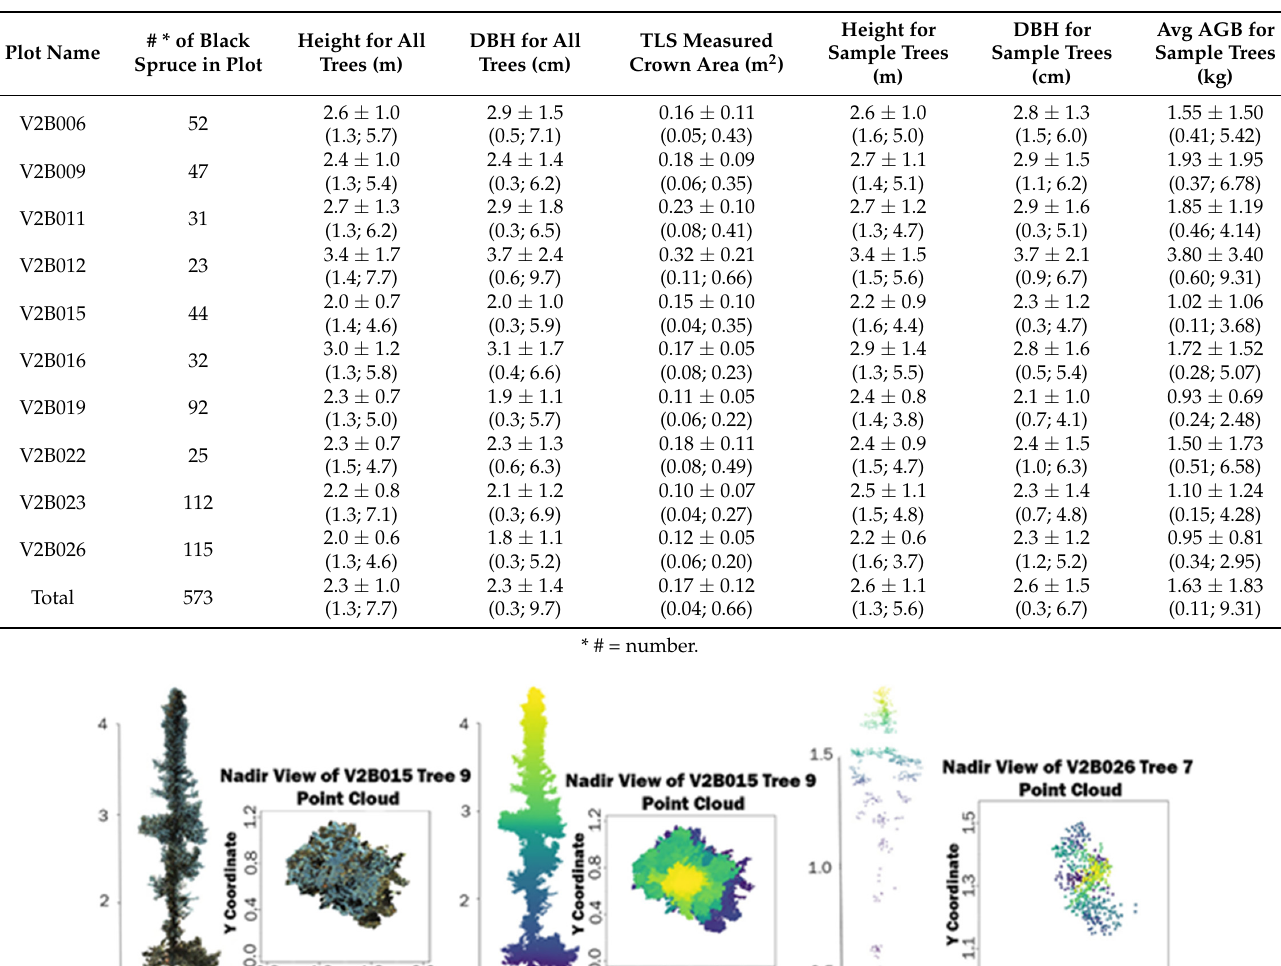
Table 2. Field-measured height and DBH of all trees within a plot as measured in the field as well as for the sample (harvested) trees used in this study. Shown as average height ± standard deviation (minimum value in range; maximum value in range). AGB = above ground biomass, DBH = diameter at breast height.